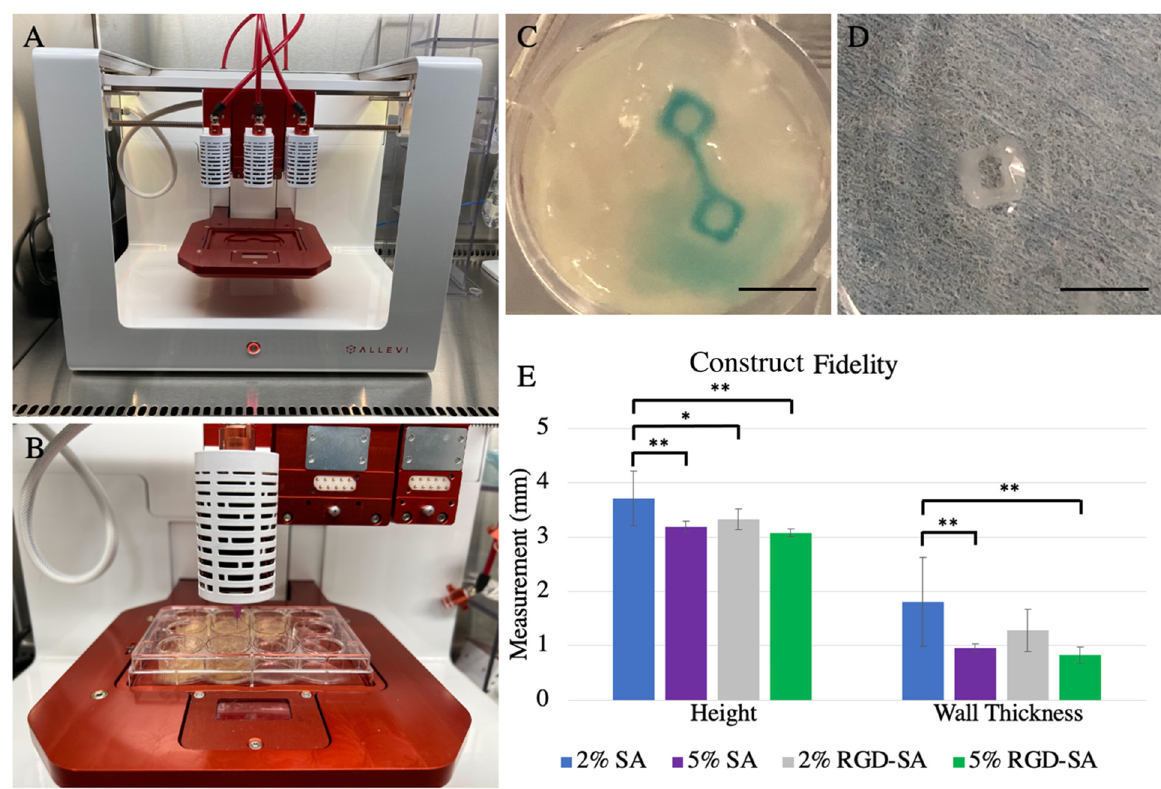
Figure 3. 3D bioprinting using the Allevi 3 bioprinter and alginates as bio-ink in freeform reversible embedding of suspended hydrogels (FRESH) for construct fidelity testing ( A ) Photograph of the Allevi 3 3D bioprinter with all 3 extruders attached. ( B ) Demonstration of 3D bioprinting of alginates in FRESH. ( C ) Open, single filament alginate boxes of 3 mm × 3 mm × 3 mm in size were printed in FRESH prior to cross-linking. Scale bar = 5 mm. ( D ) An exemplary open, single filament alginate box after cross-linking. Scale bar = 5 mm. ( E ) Construct fidelity analysis compared box maximal height and wall thickness printed using four different alginates. Mixture of 2% ( w / v ) sodium alginate (SA) demonstrated the largest box height and wall thickness, whereas 5% ( w / v ) SA with or without RGD modification demonstrated smaller box height and wall thickness. * denotes p < 0.05; **